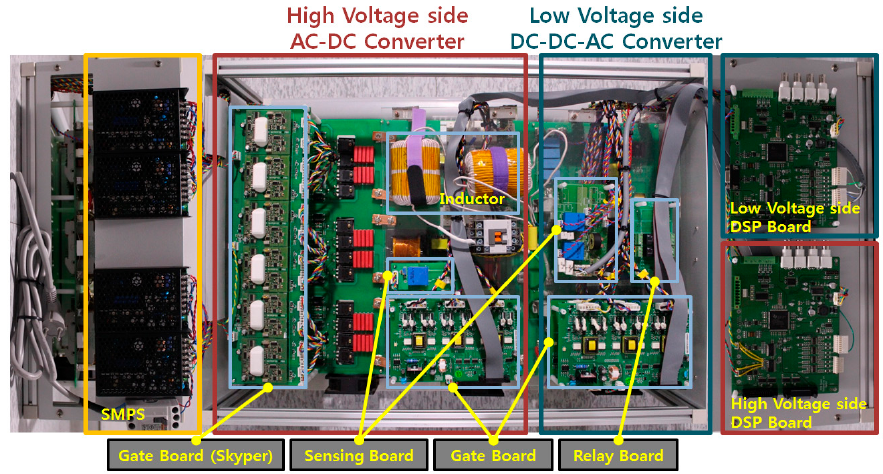
Figure 10. Single ‐ phase hardware prototype.